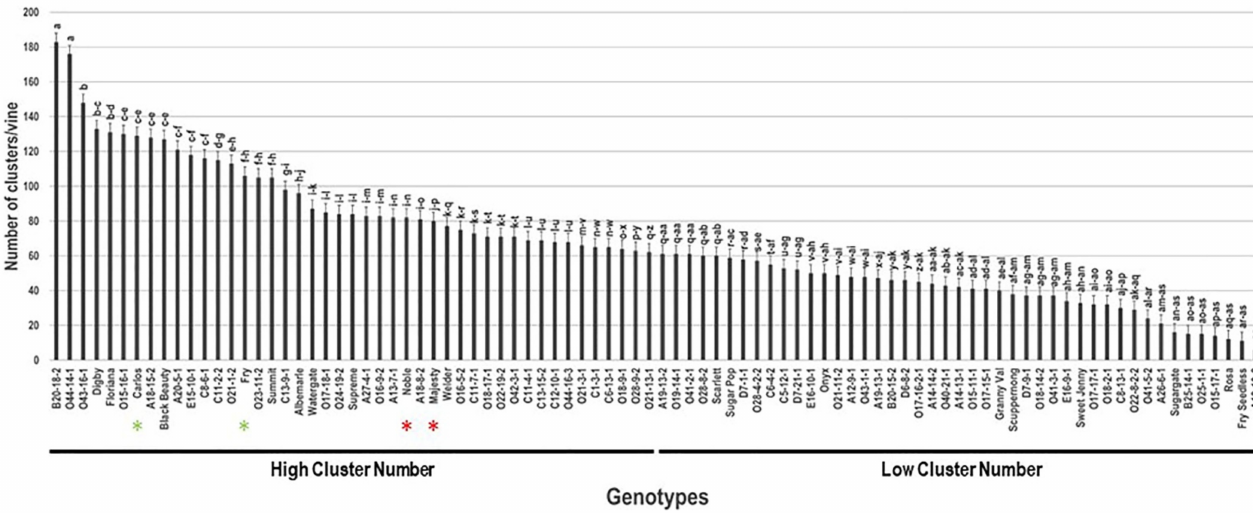
Figure 6. Characterization of number of clusters/vine (N.C/V) trait among muscadine population ( n = 90). The bars represent the mean N.C/V ( ± SD) results from three biological replicates (three vines) over three years ( n = 9). The y- axis refers to the number of clusters/vine. Means within columns for the same letter followed by different letters differ significantly by Tukey’s test ( p < 0.05). Based on median N.C/V (~61.5 clusters), the population was divided into two equal groups that displayed high and low clusters number. Other details are as in Figure